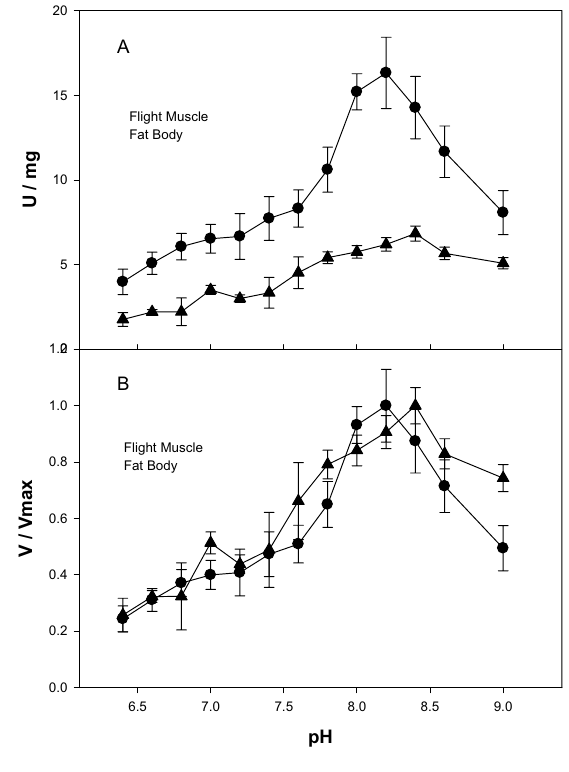
Fig. 1 – pH dependence of PFK activity from fat body and muscle homogenates. PFK activity of flight muscle (filled triangles) or fat body (filled triangles) was measured as described on Materials and Methods,inthepresenceof1mMATP,2mMfructose6-phosphateand MOPS-Tris buffers in the different pHs indicated. Values are means ± SE of at least six independent experiments. Panel A: activity is expressed as absolute activity in U/mg. Panel B: activity is expressed as relative activity to the maximal activity